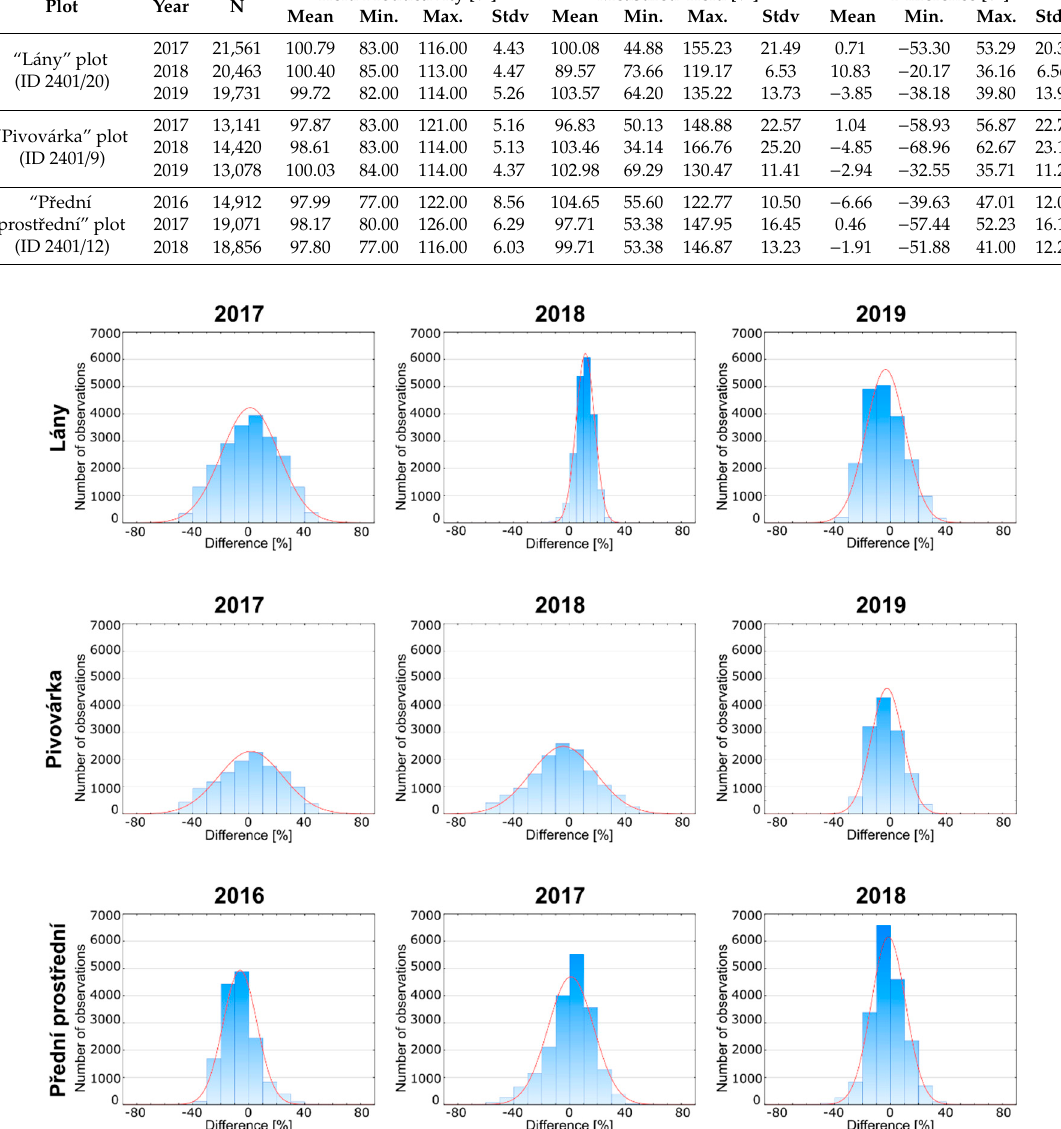
Figure 5. Histograms of di ff erences between the yield productivity zones and the measured yield. Note: the histogram for the L á ny field in 2018 was modified to increase readability, meaning the intervals of the di ff erences are equal to 5% instead of 10% as in the other histograms. The di ff erences between the yield productivity zones and the measured yield confirm that the prediction provided by the yield productivity zones led to an overestimation in five cases out of nine and an underestimation in four cases out of nine. The di ff erences in the yield prediction compared to the measured values were up to 5% in seven cases. The only two di ff erences in the predicted and measured yield were as follows: (1) the Pˇredn í Prostˇredn í plot resulted in a 6.66% overestimation